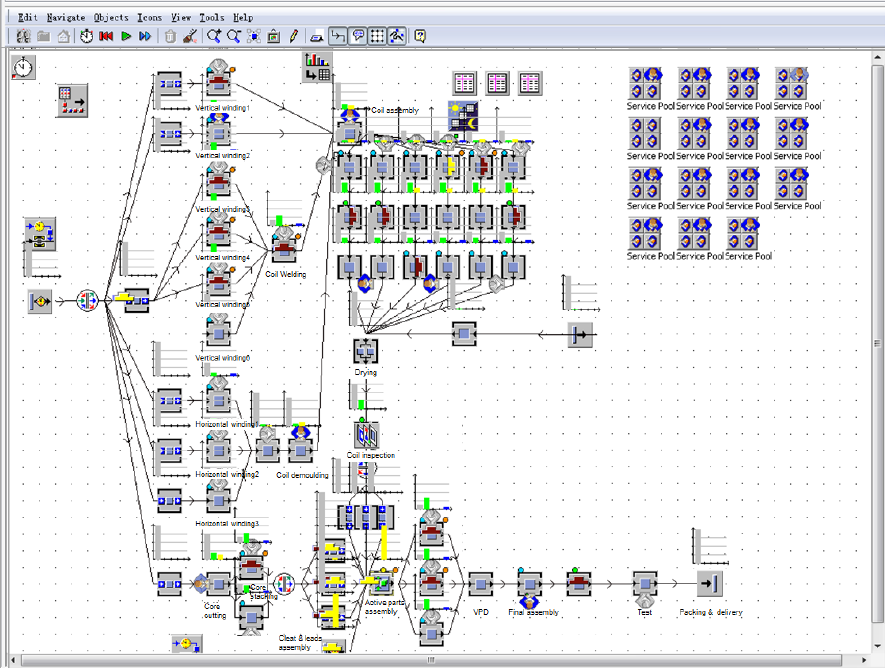
Fig. 9. Improved cloud simulation of transformer production system.